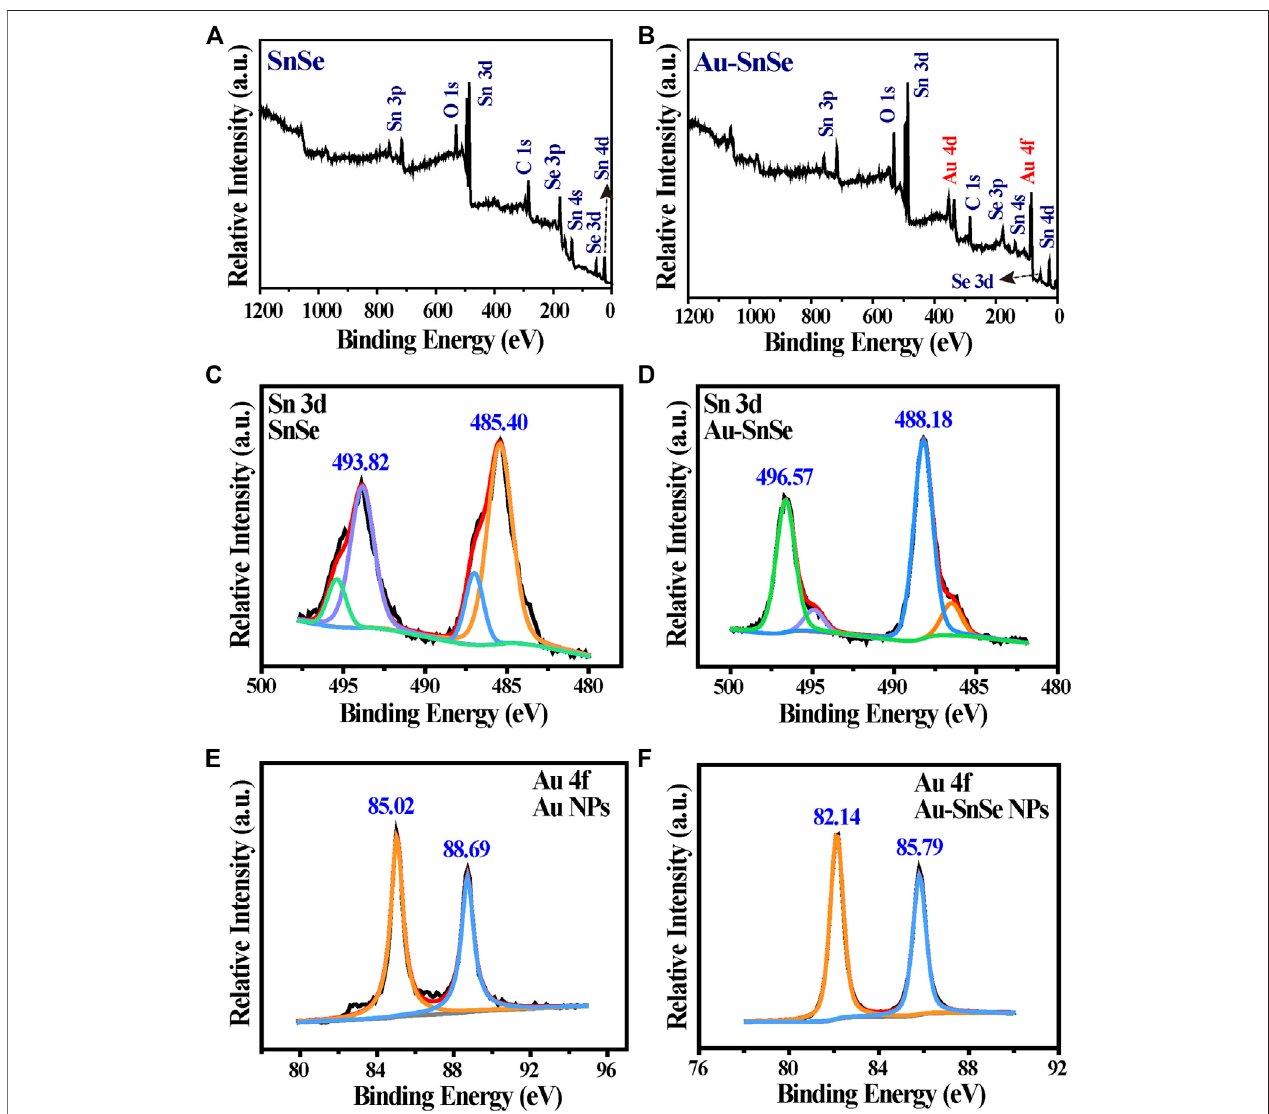
FIGURE 2 | Representative XPS spectra of (A) SnSe, (B) Au – SnSe, (C) Sn 3d of SnSe, (D) Sn 3d of Au – SnSe, (E) Au 4f of SnSe, and (F) Au 4f of Au – SnSe.